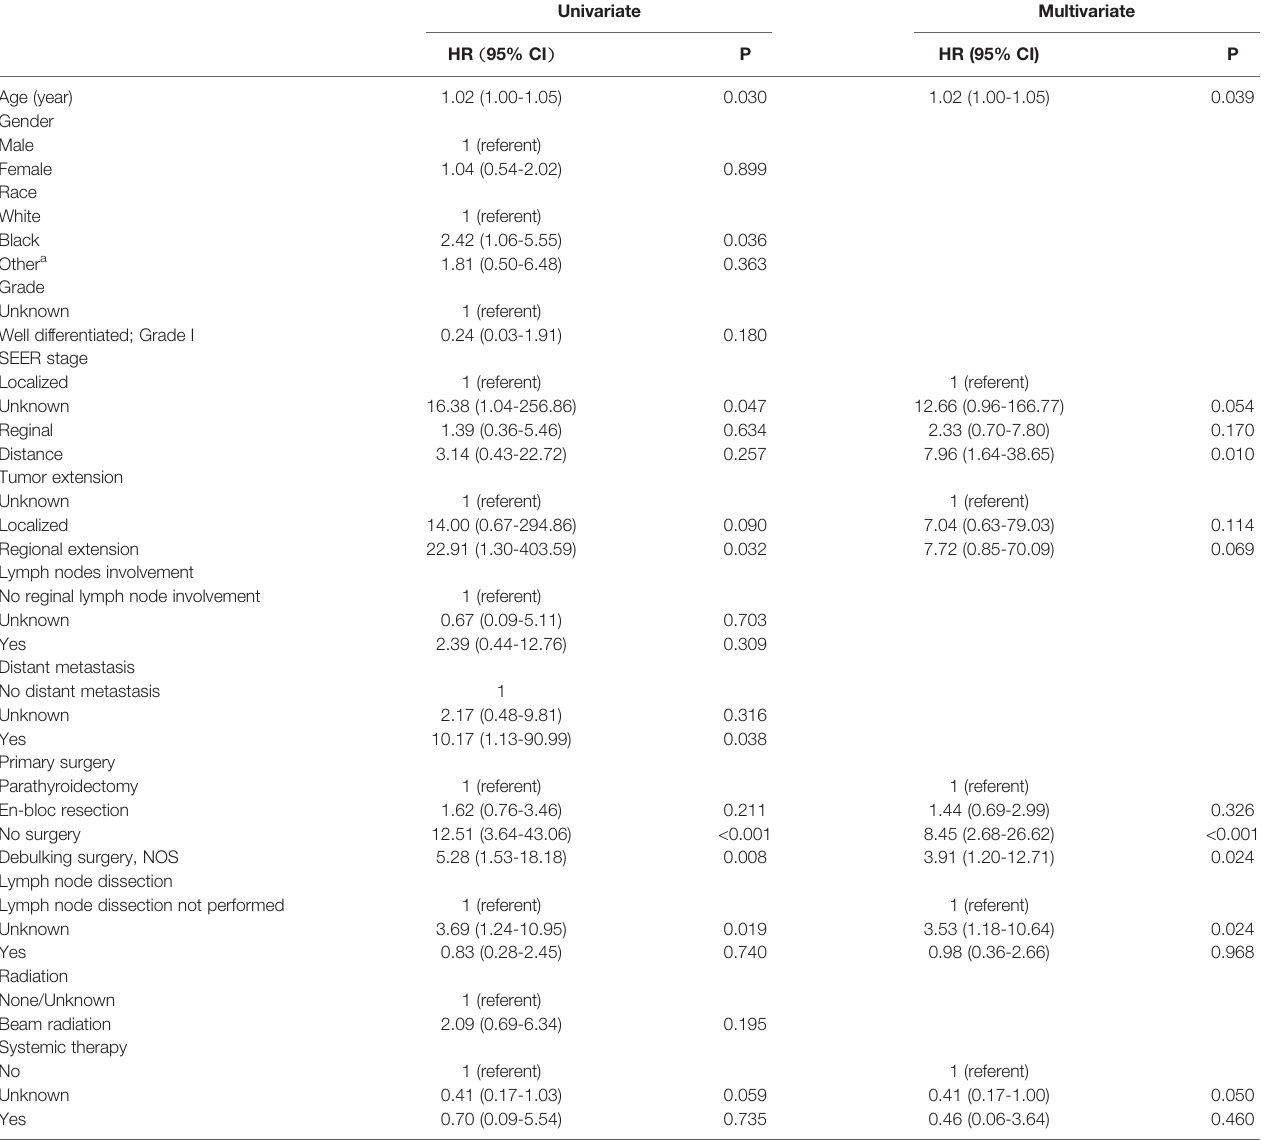
TABLE 3 | Univariate and multivariate cox proportional hazards regression model highlighting cancer speci fi c survival in the parathyroid carcinoma patient